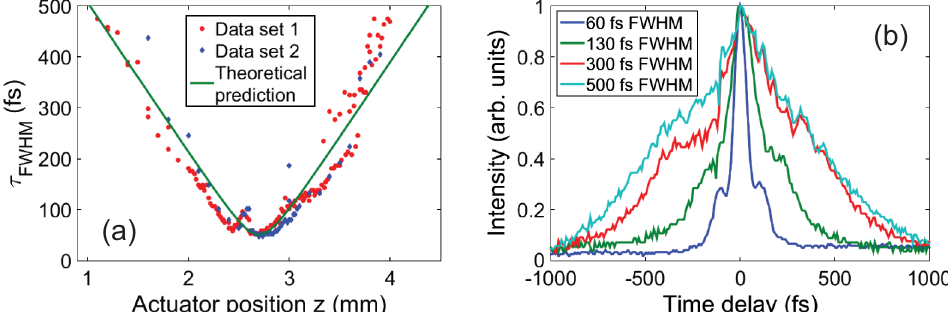
FIG. 2. Measured laser pulse durations and autocorrelations at 800 nm. (a) Compressor actuator position vs pulse duration in FWHM, dots are experimental data, and the green curve is fitted by a model based on group velocity dispersion of the single-grating compressor. (b) Sample autocorrelation traces for pulse duration of 60, 130, 300, and 500 fs